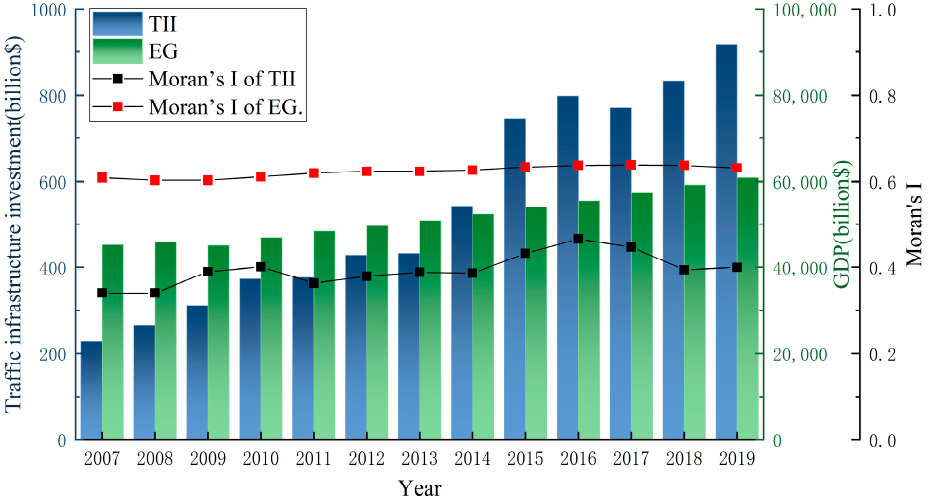
Figure 5. Aggregate trends and Moran’s I of TII and EG from 2007 to 2019.